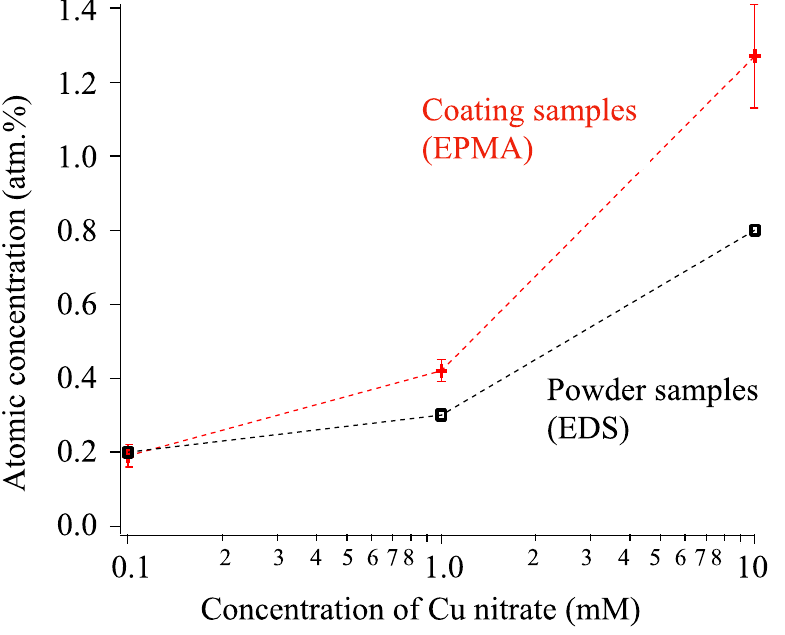
Figure 11. Atomic concentration of Cu incorporated into powder and coating samples.